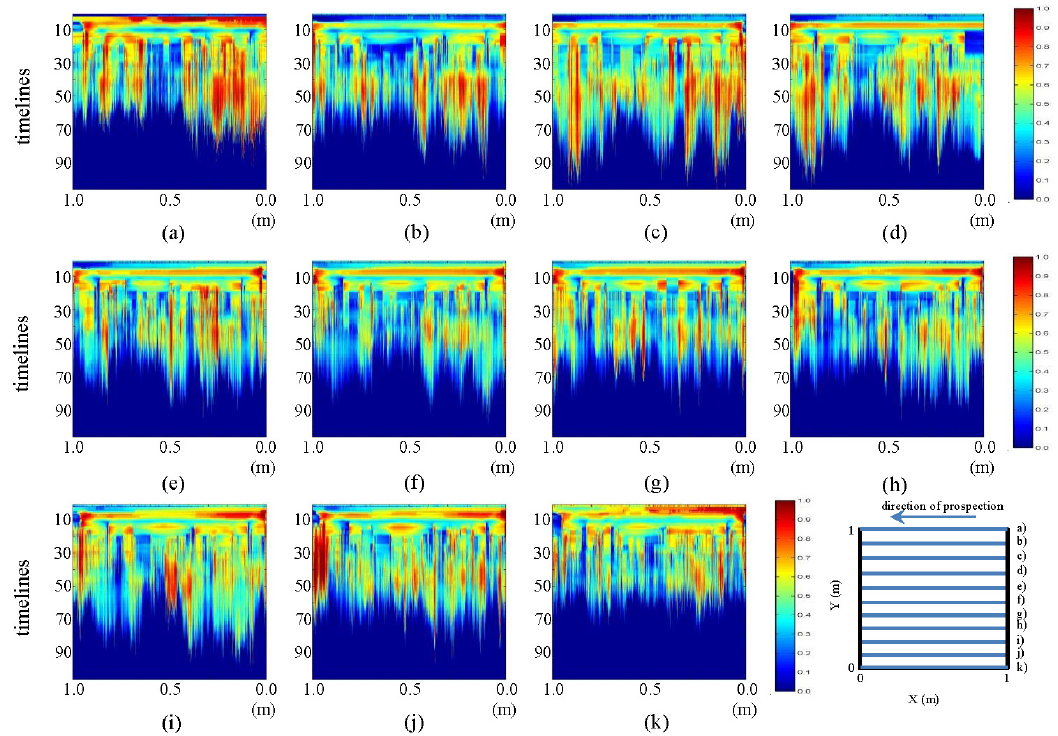
Figure 13. Horizontal profiles: pre-processed images for the initial state. ( a – k ) are profiles s1 to s11, respectively.